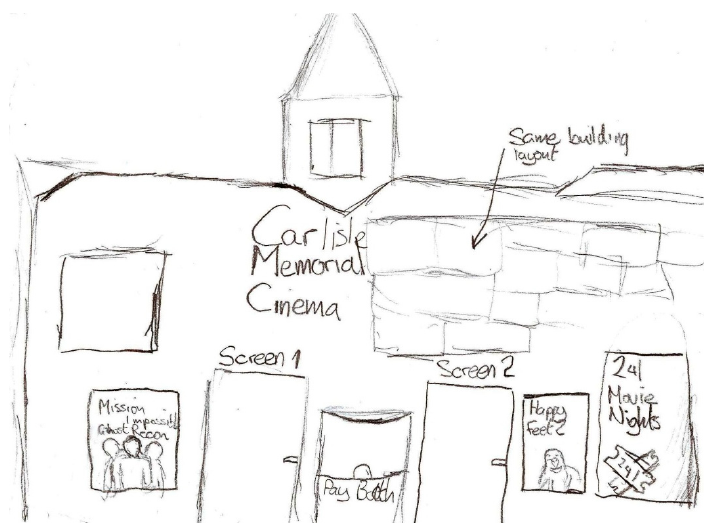
Figure 8. Reuse option ‘cinema’.